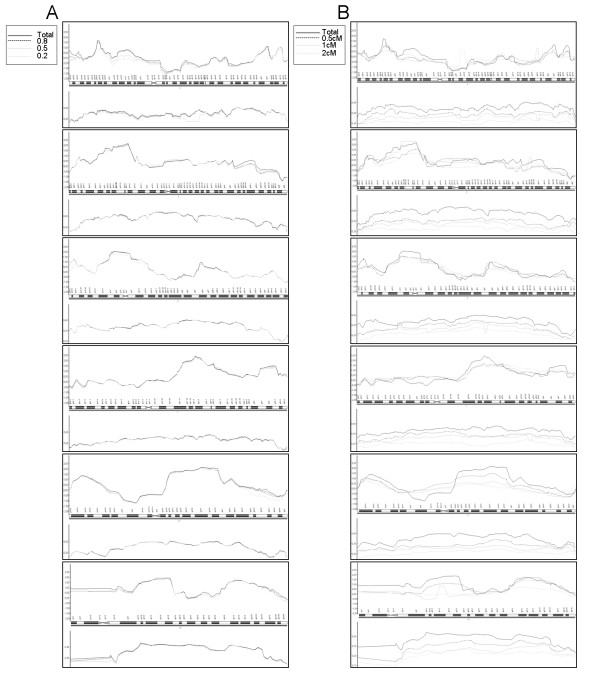
LOD score values and information content. LOD score values (top part of each panel) and information content (bottom part of each panel) in the six candidate regions selected, taking into account: A) LD between marker loci (r2 > 0.2/0.5/0.8), and B) marker densities (0.5 cM/1 cM/2 cM).